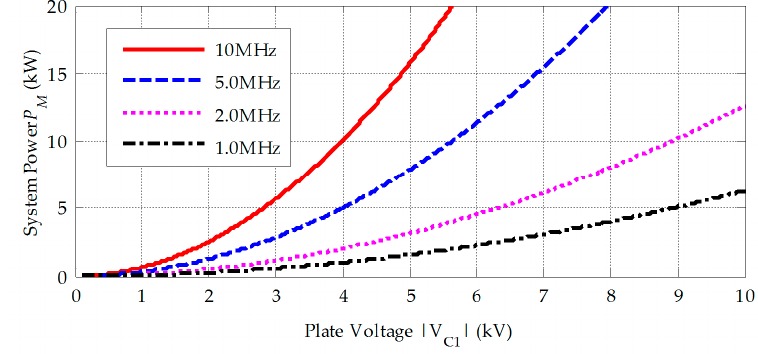
Figure 7. The maximum achievable system power P M at different f s and | V C 1 |, when C M = 10 pF and | V C 1 | = | V C 2 |.